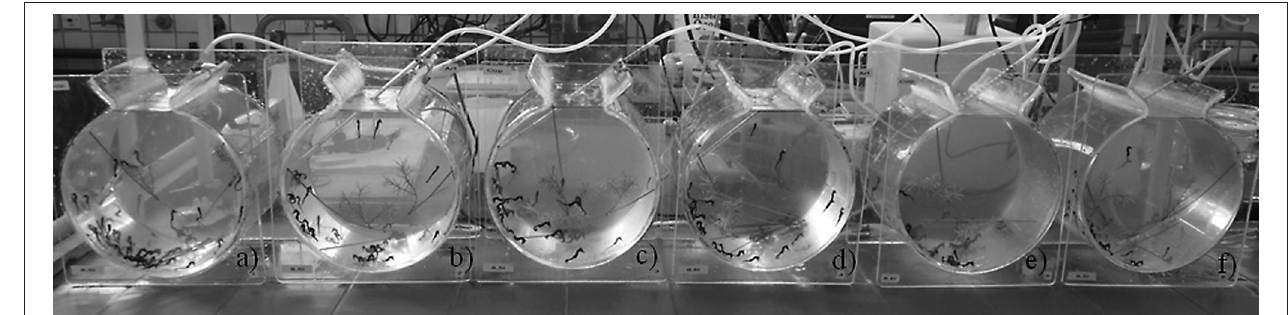
FIGURE 1 | Experimental setup for survival and growth analyses of Hippocampus reidi . (a) Diet Art/Cop 1, (b) diet Art 1, (c) diet Art/Cop 2, (d) diet Art 2, (e) diet Art/Cop 3, (f) diet Art 3.